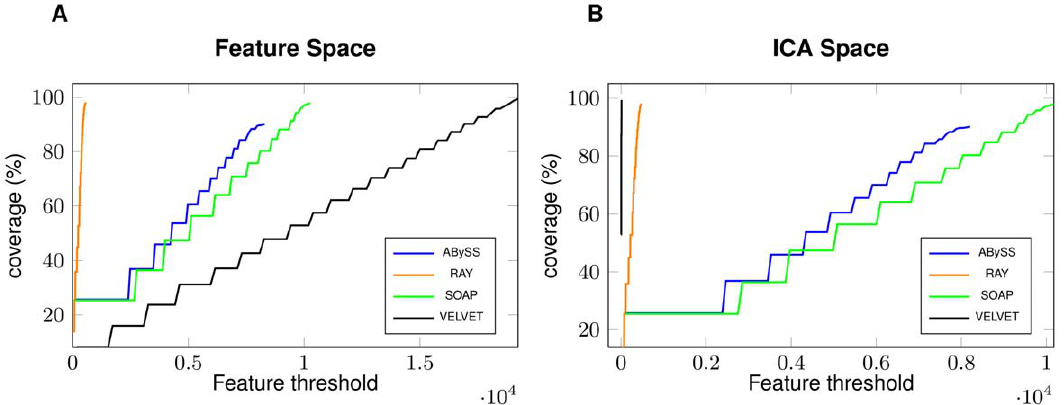
Figure 5. Feature Response Curve and ICA features: Simulated Short Reads. Figure A shows the FRC for 4 assemblers on Brucella suis simulated dataset (read length 100 bp, insert size 600 bp and coverage 80 | ) when using all the feature space. Figure B shows the FRC computed on the ICA-selected features. doi:10.1371/journal.pone.0031002.g005 PLoS ONE |